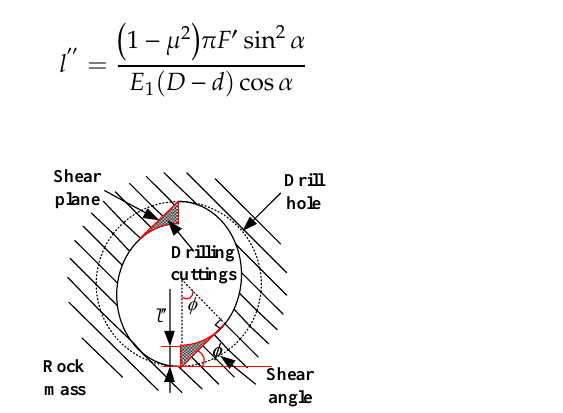
Figure 5. A schematic diagram of the force of the end face of I-I.